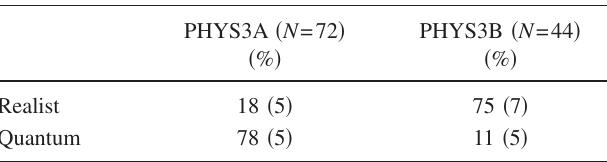
TABLE IV. Student response to the quantum wave interference essay question from two recent semesters of PHYS3. Numbers in parentheses represent the standard error (cid:1) in percent (cid:2) on the